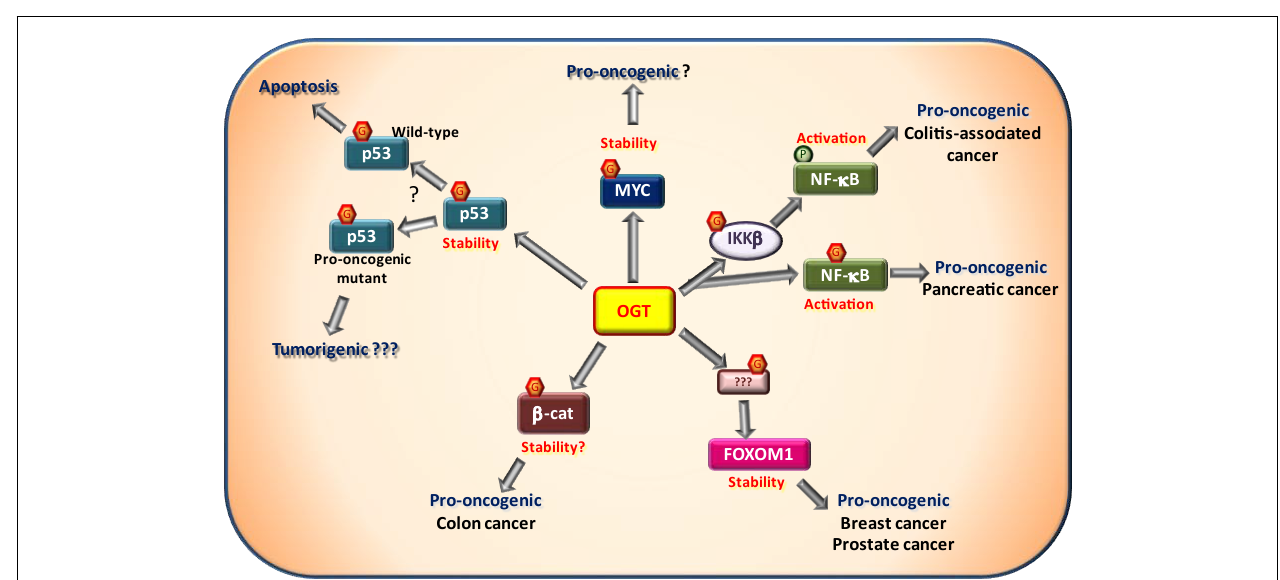
an unknown substrate and mechanism, OGT prevents FOXM1 degradation and thus promotes tumor development in breast cancer and metastasis in prostate cancer. β -Catenin, involved in cell adherent junctions, is also central to theWnt/ β -catenin pathway as a transcription factor in complex notably with LEF/TCF co-factors. Once activated, β -catenin promotes tumorigenesis, especially colorectal and liver cancers. Increased O -GlcNAcylation levels of β -catenin have been observed in colon carcinoma cells. Furthermore, interaction of OGT with β -catenin is stimulated during serum-induced proliferation in HeLa cells.These observations support a positive role of O -GlcNAc-modified β -catenin in cell proliferation.The well known tumor suppressor p53 is O -GlcNAcylated at Ser149 which prevents the phosphorylation atThr155 by the COP9 signalosome.This results in an inhibition of p53 degradation. O -GlcNAcylation of p53 promotes p53 stability and thus its tumor suppressor activity in physiological context. In case of pro-oncogenic p53 mutants, O -GlcNAc-mediated stability of p53 may favor pro-oncogenic processes.This hypothesis has not been addressed experimentally